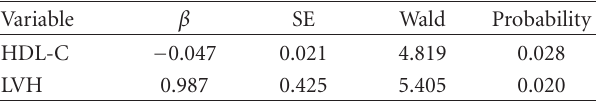
Table 6: Cox hazard stepwise regression analysis for cardiovascular